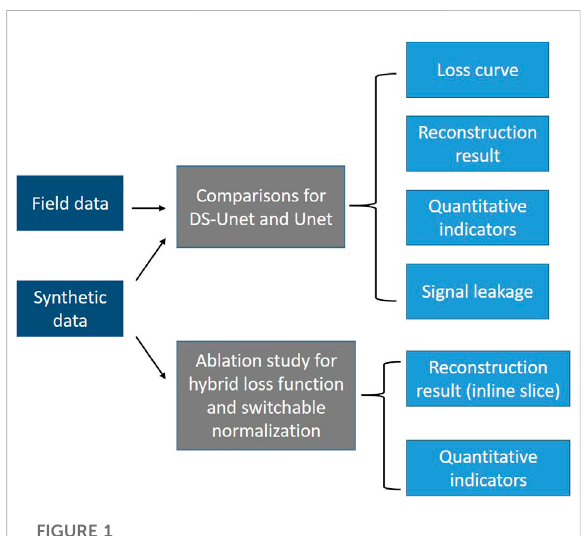
FIGURE 1 Scheme of the numerical experiments and